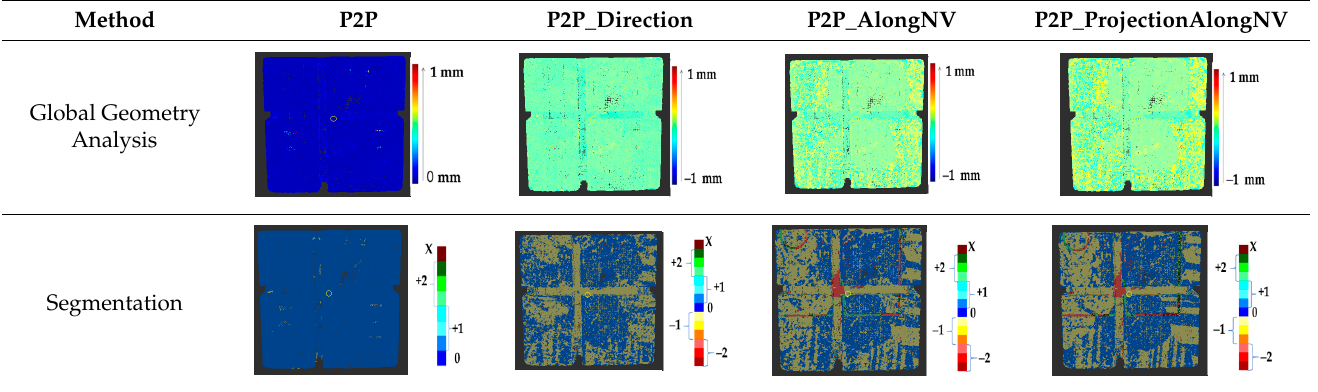
Table 21. Analysis and results for the dataset of NGS1.